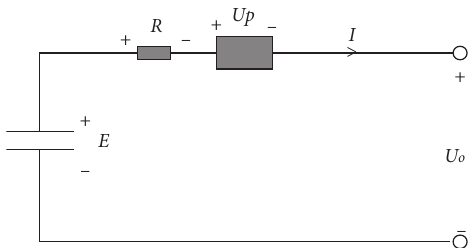
Figure 3: Simple model of a lithium-ion battery for pure electric